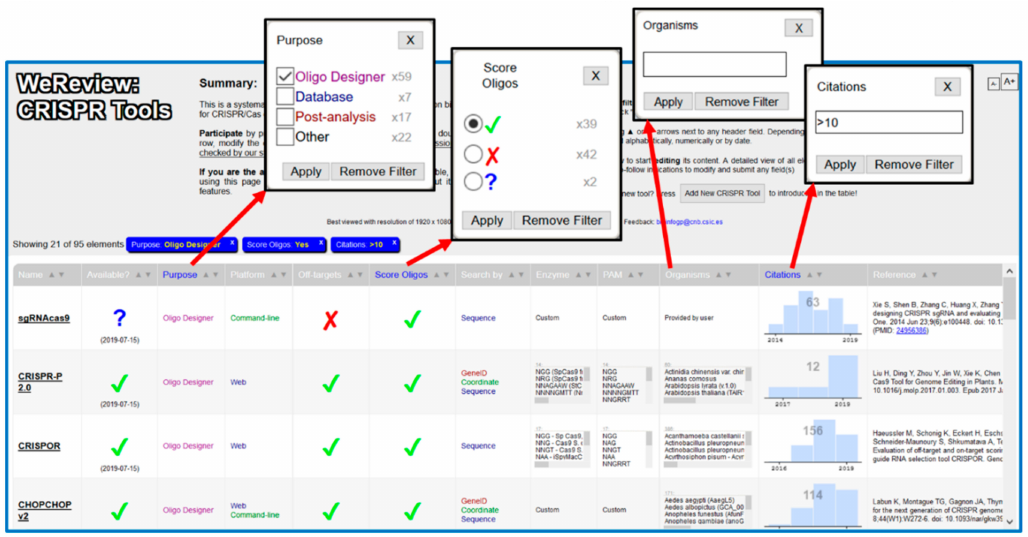
Figure 1. Screenshots of WeReview web interface. The main table, together with some of the dialogs for introducing filters are